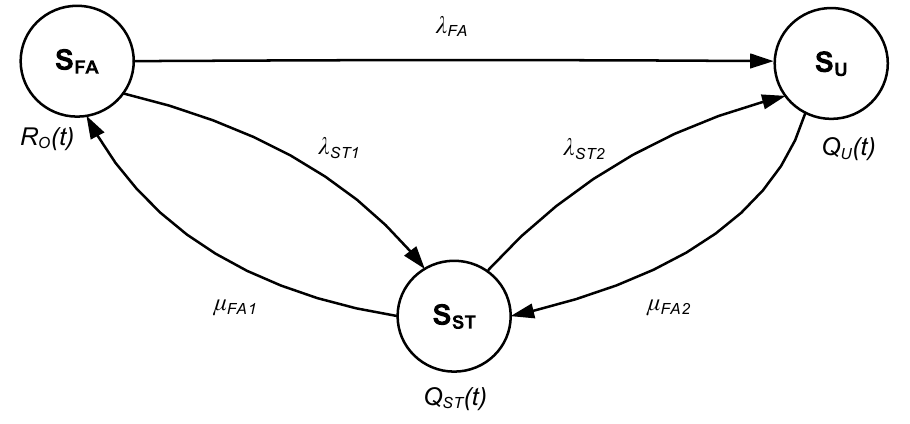
Figure 2. Relations in a PSS in TTD. Symbols in Figure 2 represent: